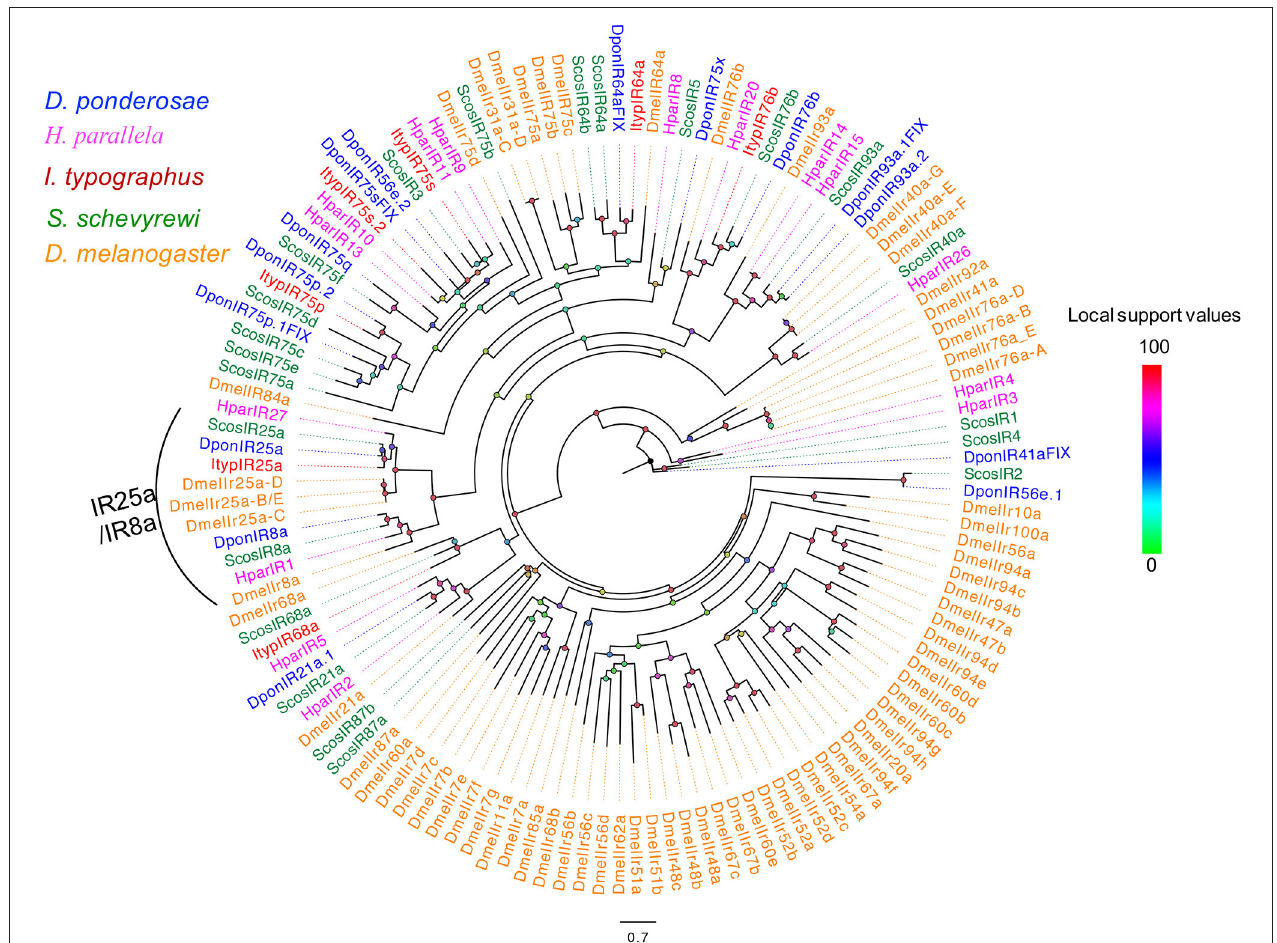
FIGURE 2 | Phylogenetic tree of candidate ScosIRs with ionotropic receptor sequences from other insects. Tcas, T. castaneum ; Dpon, D. ponderosae ; Hpar, H. parallela ; Ityp, I. typographus ; Dmel, D. melanogaster ; Scos, S. schevyrewi